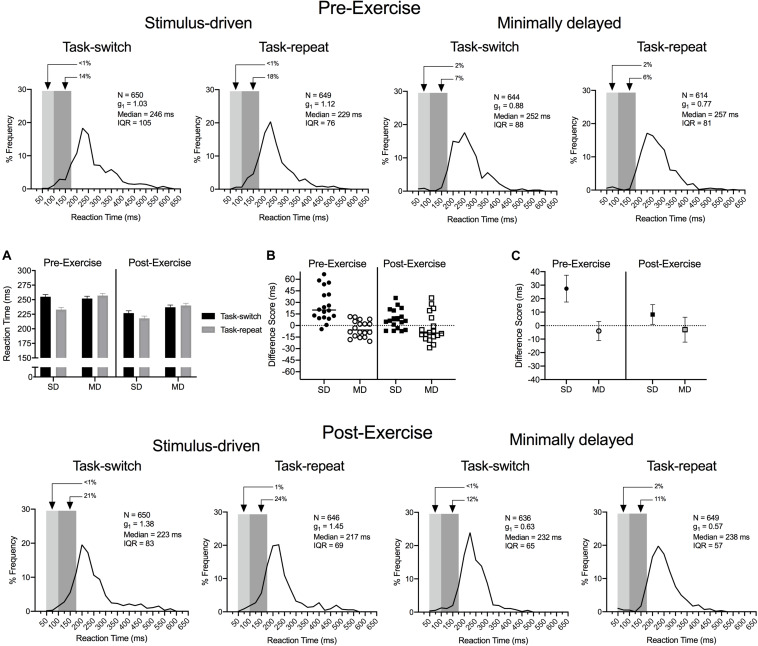
Experiment 1: The main panels show reaction time (RT) percent frequency histograms (bin width = 25 ms) for pre- and post-exercise stimulus-driven (SD) and minimally delayed (MD) task-switch and task-repeat saccades. For each panel the light and dark gray rectangles represent anticipatory (<100 ms) and short-latency (100 to <200 ms) responses, respectively. Inset panel (A) shows group mean RT for pre- and post-exercise task-switch and task-repeat trials with error bars representing 95% within-participant confidence intervals. Inset panels (B,C) represent participant-specific and group mean RT difference scores (task switch minus task-repeat), respectively. The errors bars in (C) represent 95% between-participant confidence intervals and the absence of overlap between an error bar and zero (i.e., horizontal dashed line) represents a reliable effect inclusive to a test of the null hypothesis.